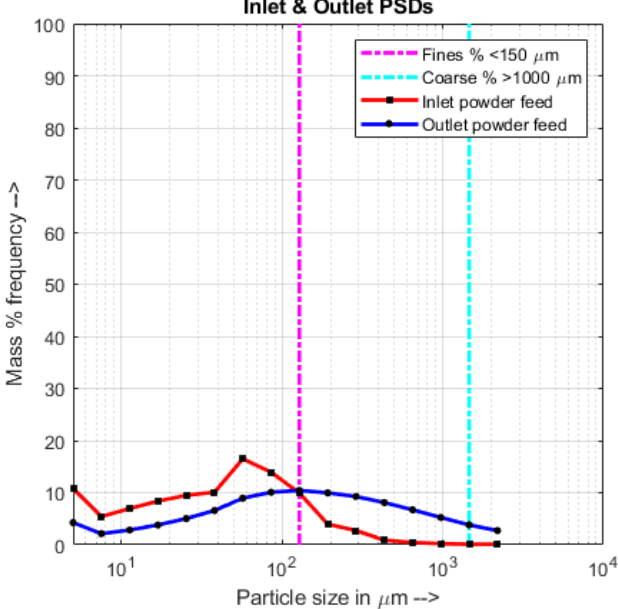
Figure 9. PSD trend obtained from a PBM pulse tracer study for unfavorable granulation case from the DOE of Kumar et al., 2016 [19].